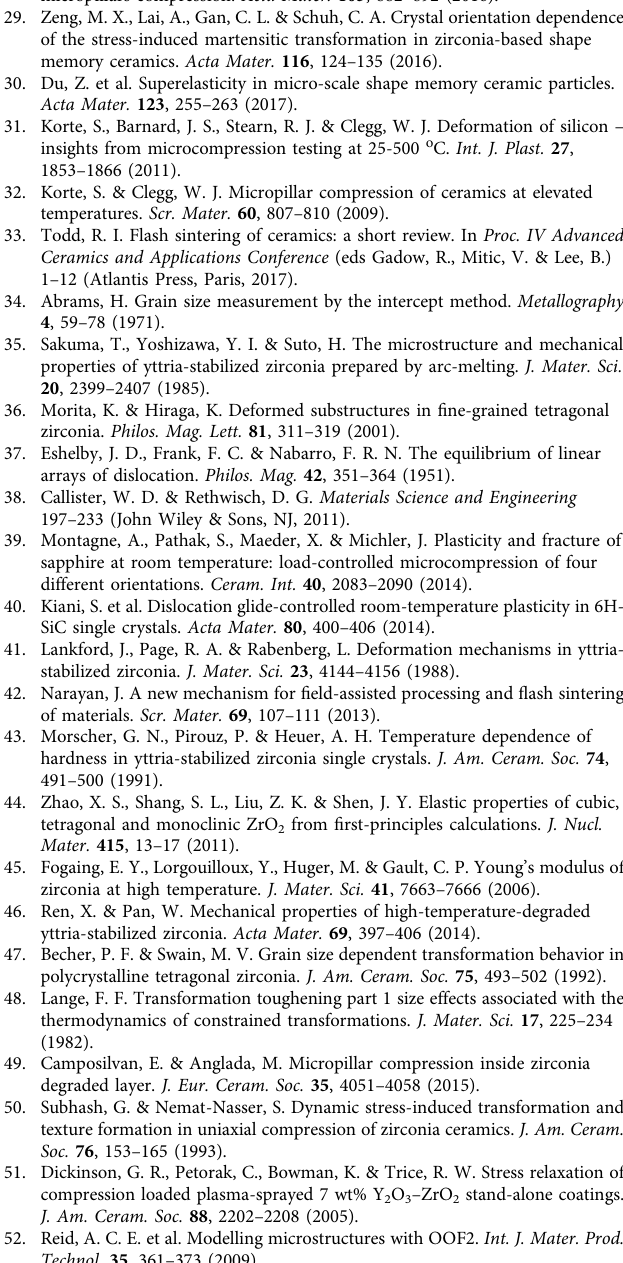
solved using OOF2 52 , an open source implementation of the fi nite-element method. The relative numerical tolerance was set to 1× 10 − 10 . The simulation used 40GB of RAM and a wall time of ~4 h (See Supplementary Methods for detailed